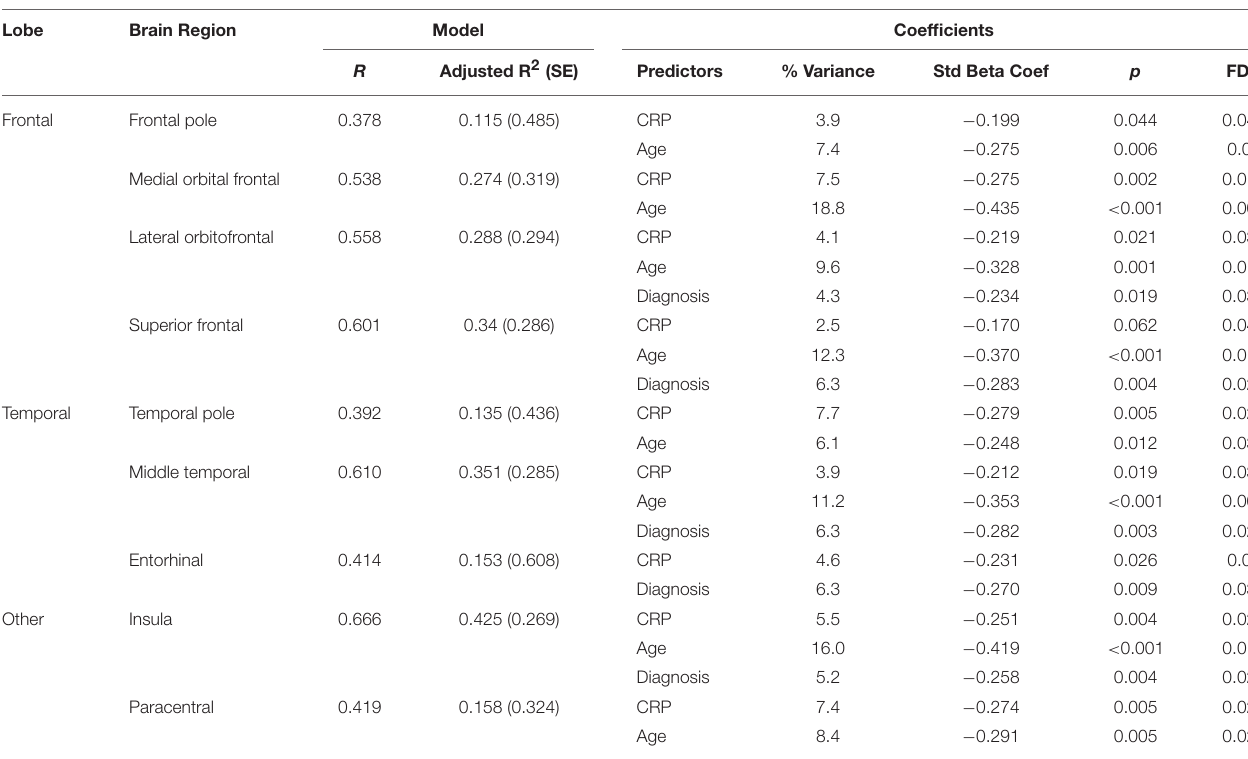
TABLE 11 | Results of regression analysis showing significant contributions of diagnostic (Dx) group (schizophrenia or control), age, sex, and C-Reactive Protein (CRP) to cortical thickness. Lobe